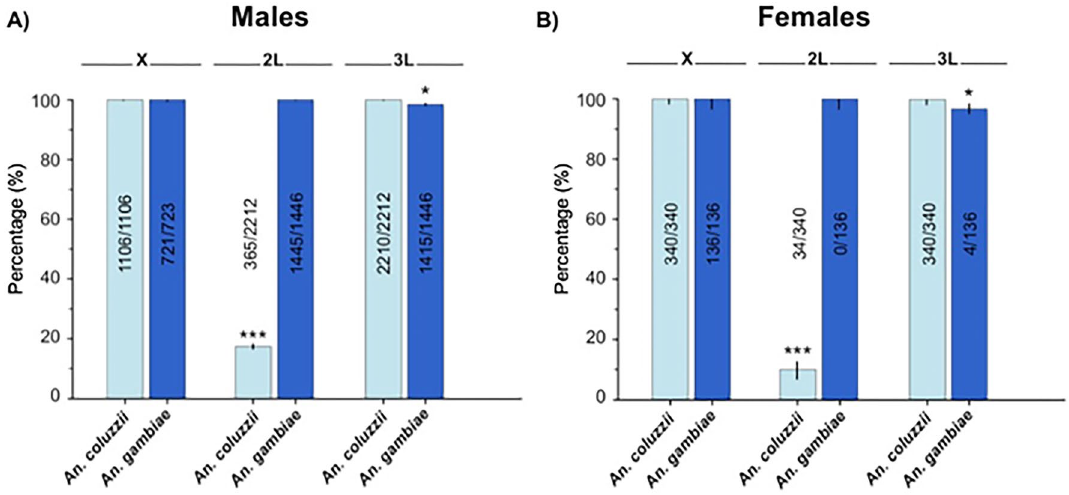
Figure 3. Association between swarm type and divergence islands—Relative proportions of pericentric islands genotypes matching that of the swarm they were captured from for each chromosome in males ( A ) and females ( B ). Sample sizes are indicated and vertical whiskers show 95% confidence intervals. P -values are: P < 0.001***, P < 0.01**, P < 0.05*.